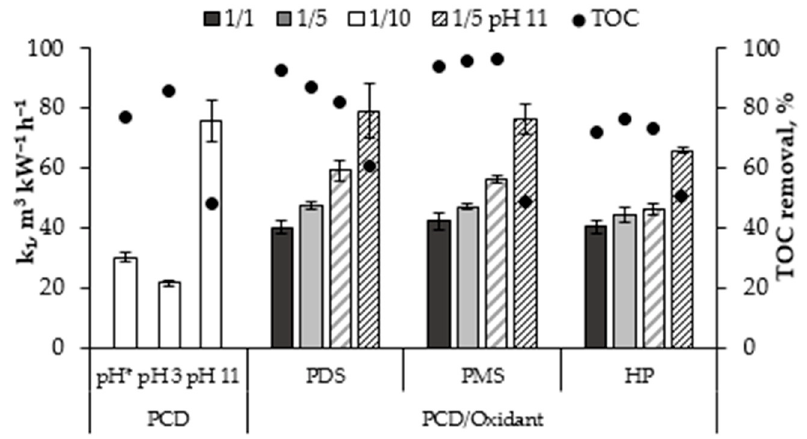
Figure 4. Effect of pH and VMN/oxidant molar ratio on the target compound PCD oxidation rate constant k 1 and TOC removal ([VMN] 0 = 13.5 µM, unadjusted pH*, treatment time for TOC removal 2 h).